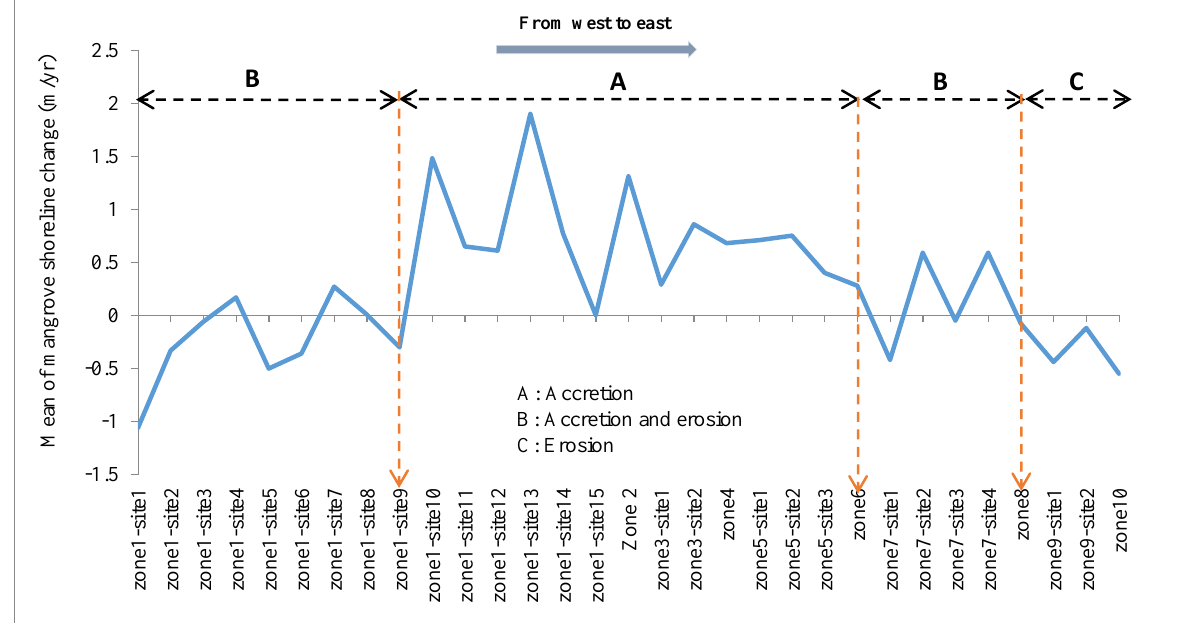
Figure 4. Mangrove boundary changes from the West to the East coasts of the Hormozgan